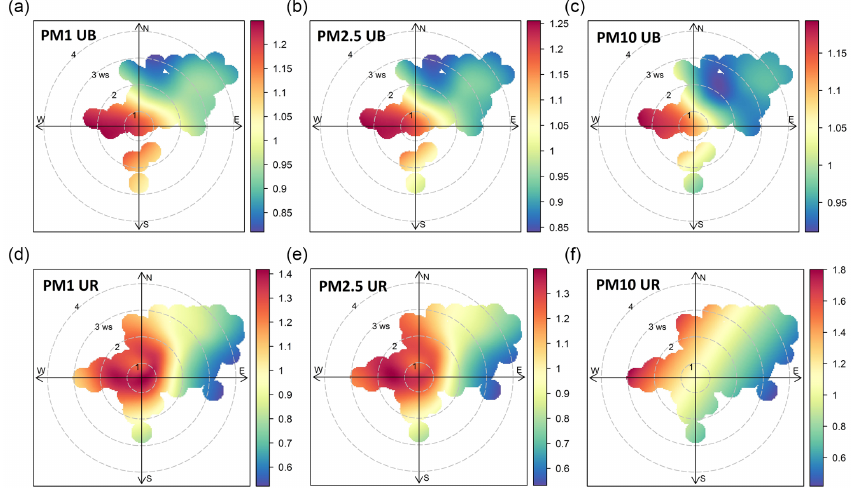
Figure 6. Bivariate (polar) plots of PM in different size fractions at urban background (UB) and urban roadside (UR) sites. Panel descriptions (a) PM 1 UB, (b) PM 2 . 5 UB, (c) PM 10 UB, (d) PM 1 UR, (e) PM 2 . 5 UB and (f) PM 10 UR. The PM mass concentration data in each plot are normalized to allow for easy comparison between the different sites and PM size fractions investigated. However, note the scale bars are different for each panel to allow for easier interpretation.